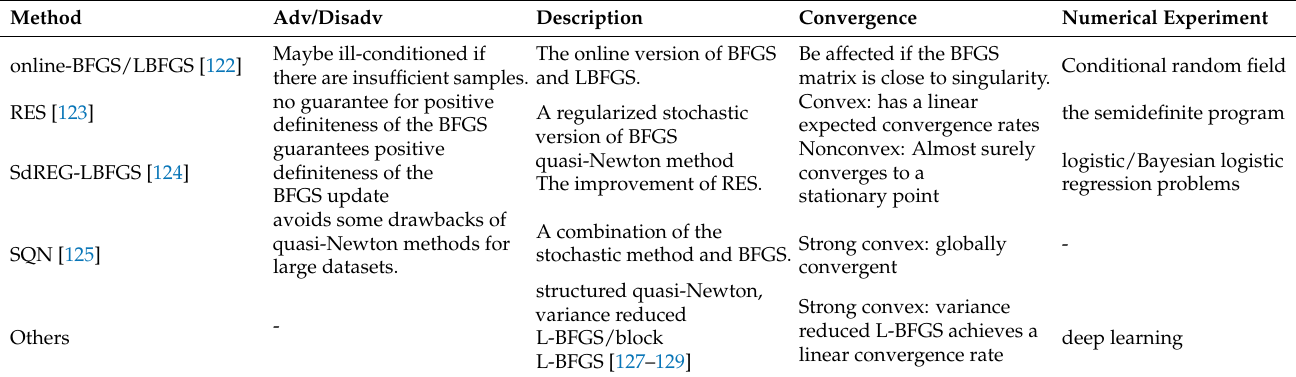
Table 8. Summary of the high-order methods.